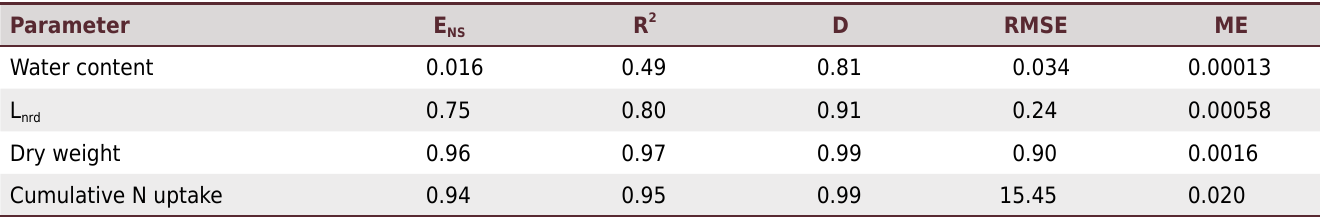
Figure 3. Overall comparison of soil water content between measurement and simulation.